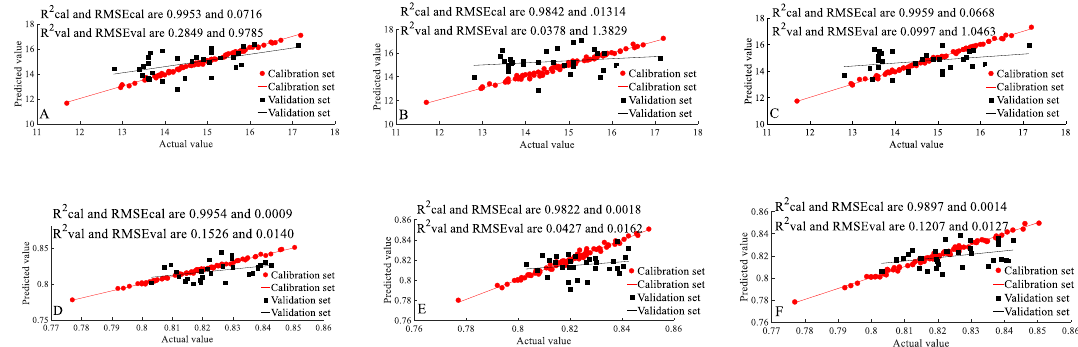
Figure 2. TSSC and water content detection based on raw spectrometer datafrom 900–1700 nm from the ( A , D ) stem end position, ( B , E ) equator position, ( C , F ) blossom end position; ( A – C ) TSSC detection, ( D – F ) water content detection.